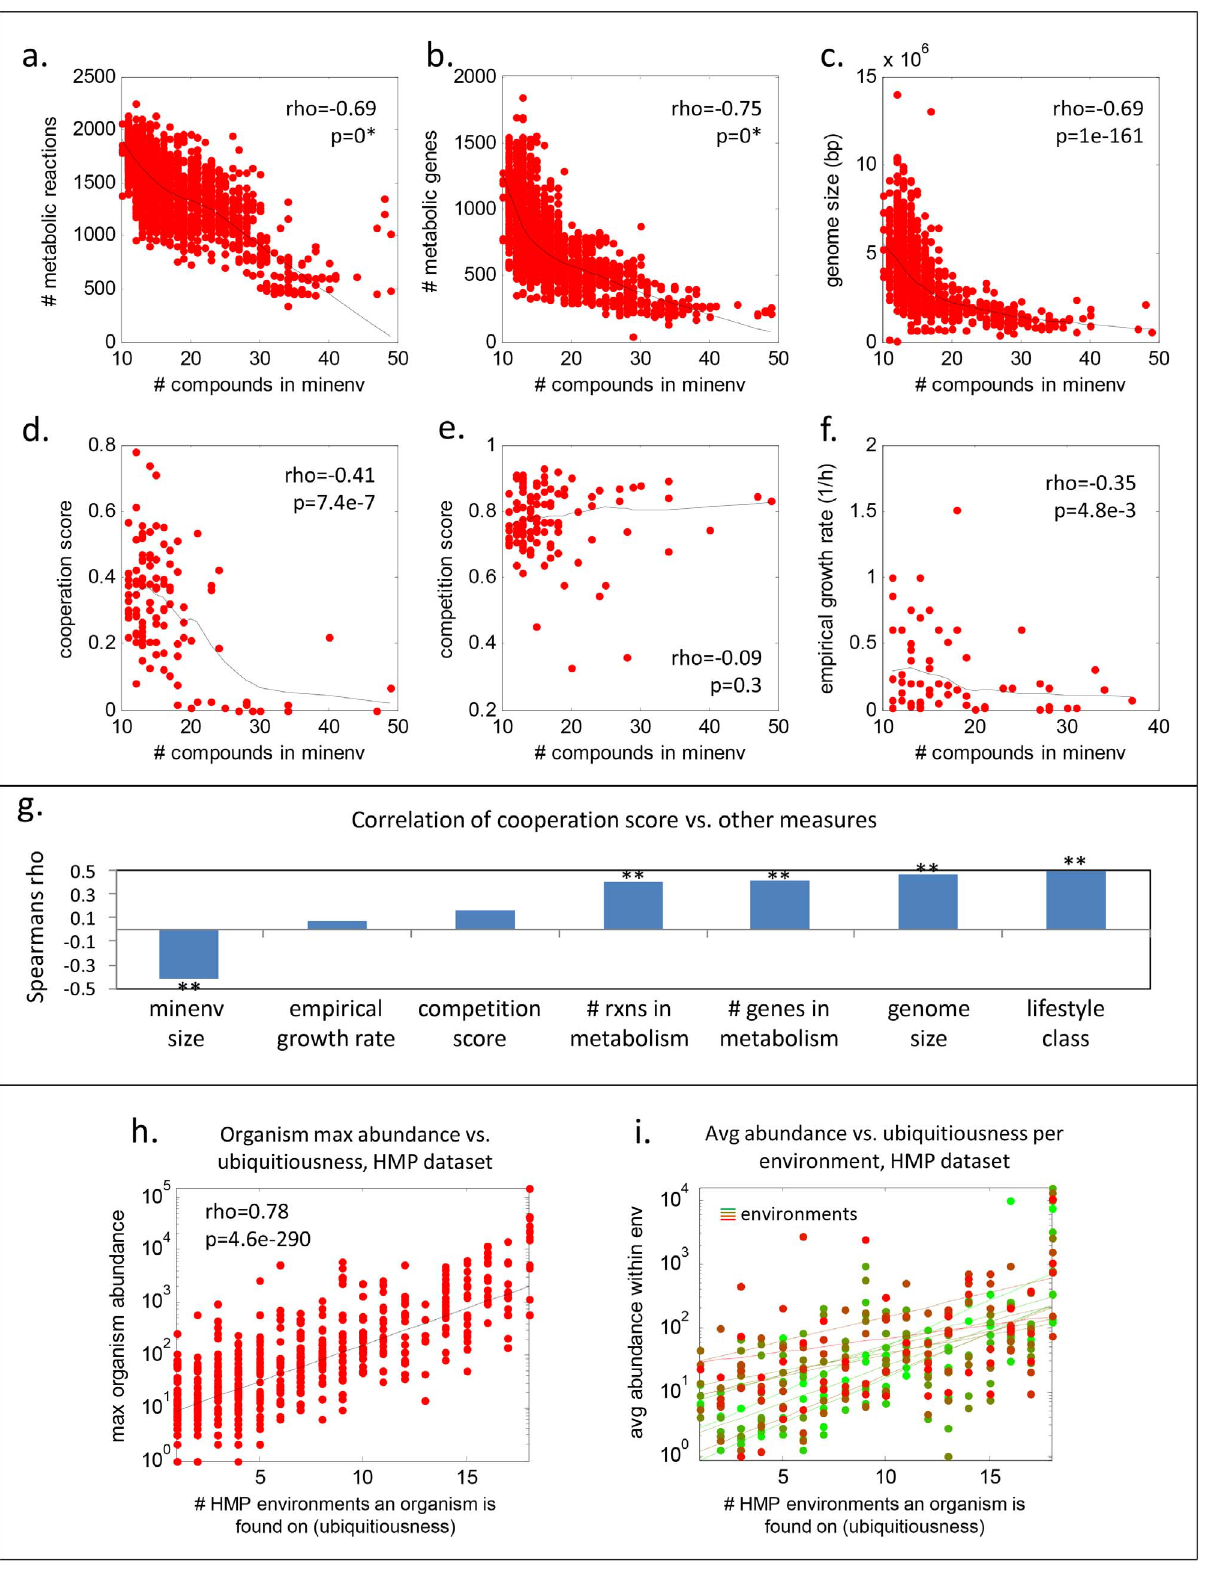
Figure 4. Nutritional fastidiousness scales with various ecological and lifestyle factors. The plots compare minenv size to (A) the number of metabolic reactions, (B) the number of metabolic genes, (C) the size of the genome, (D) cooperation score, (E) competition score, and (F) growth rate for all organisms we were able to map. Cooperation and competition scores were computed as averages per organism of all organism-organism scores from [7], and empirical growth rates were taken from [38]. A higher cooperation(competition) score denotes more cooperation(competition).